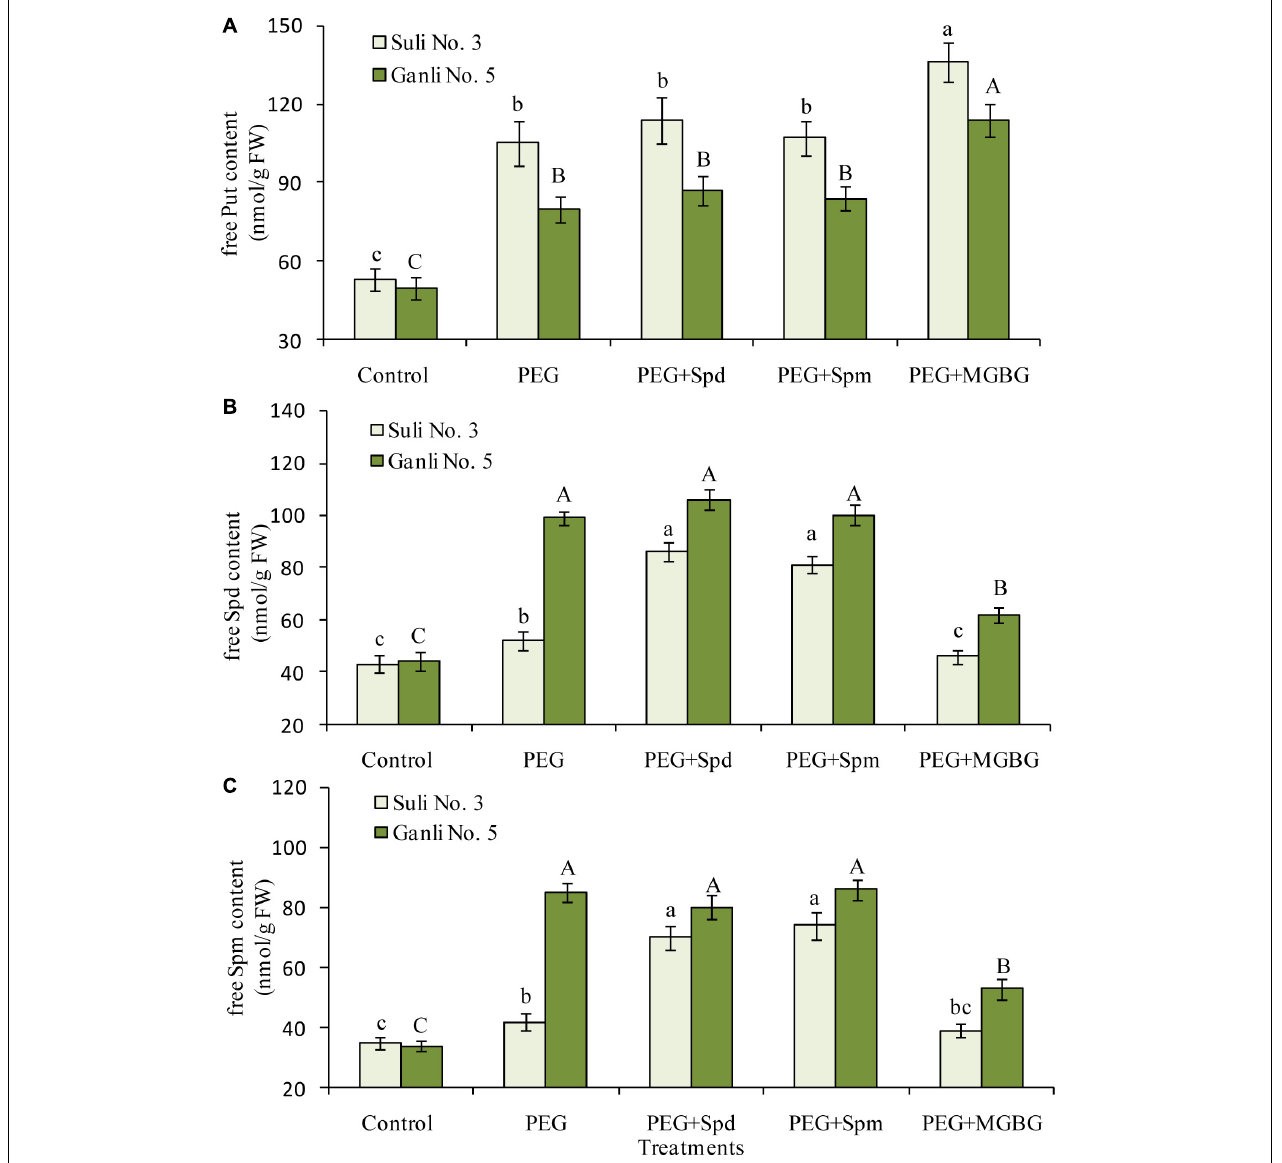
FIGURE 4 | Changes in the contents of free Put (A) , free Spd (B) , and free Spm (C) in the plum seedling roots under PEG, exogenous Spd, Spm, and MGBG. Control: treatment without PEG or the other reagents (–0.15 MPa); PEG: treatment with PEG (–0.85 MPa); PEG + Spd: treatment with PEG and Spd (1 mM); PEG + Spm: treatment with PEG and Spm (1 mM); PEG + MGBG: treatment with PEG and MGBG (0.5 mM). The data here were means ( n = 9) ± standard error of 3 independent experiments. Significant differences between treatments are indicated with letters, with upper and lower letters for each cultivar ( P <